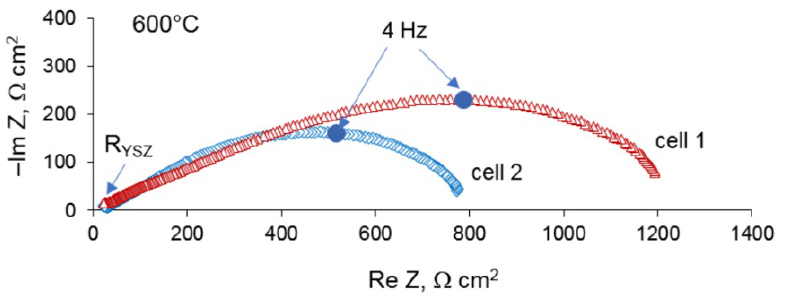
Figure 4. Impedance spectra of the cells 1 and 2 at 600 °C.